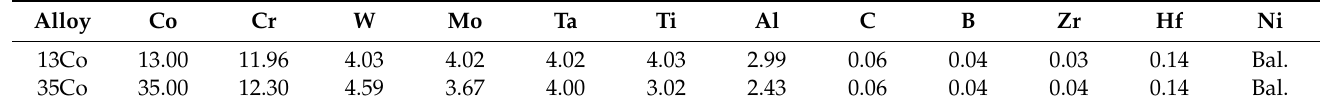
Table 1. Nominal compositions of the two alloys